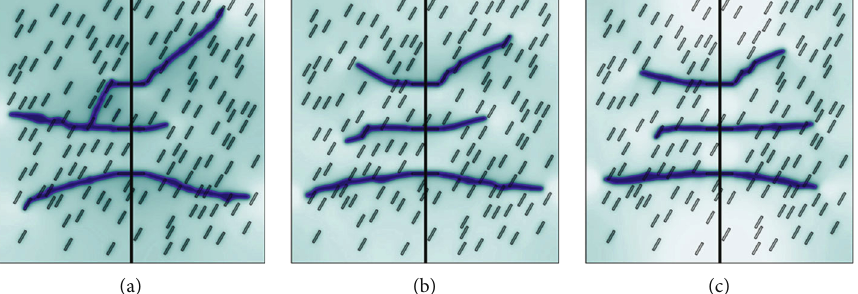
= 5 MPa , (b) Δσ = 10MPa , and (c) H H